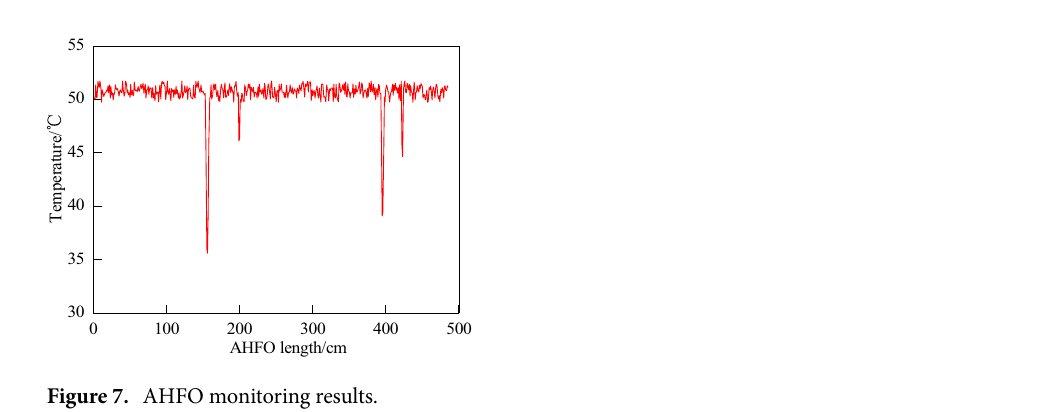
Figure 6. Laboratory equipment.